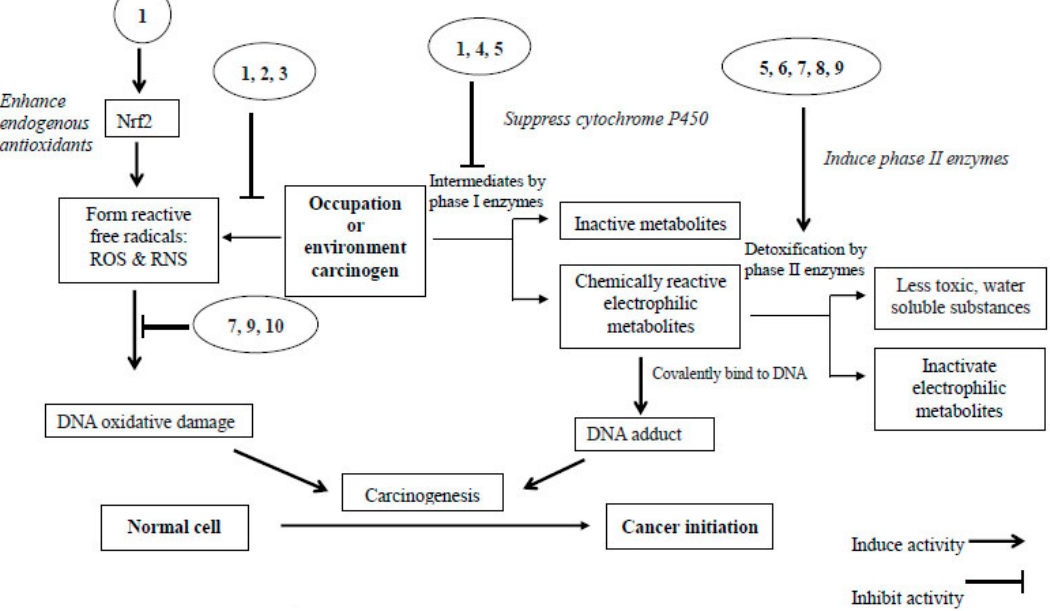
Figure 3. Intervention of polyphenols at lung cancer initiation stage [78–80]. 1 , Quercetin; 2 , Naringin; 3 , Luteolin; 4 , Keampferol; 5 , Proanthocyanidine; 6 , Baicalein; 7 , Catechins; 8 , Isothiocyanate; 9 , Epigallocatechin gallate; and 10 , Rutin.